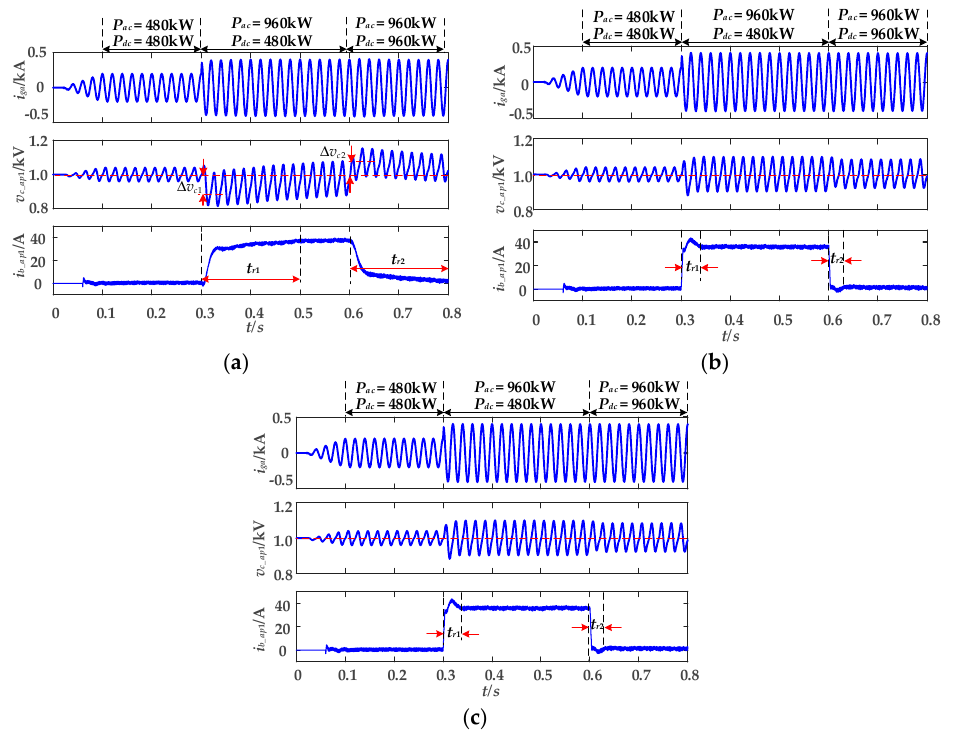
Figure 15. Verification of proposed battery side capacitor voltage control strategy. ( a ) Without estimated feedforward component. ( b ) Utilizing MAF each SM with estimated feedforward component. ( c ) Utilizing proposed common MAF each phase arm with estimated feedforward component.